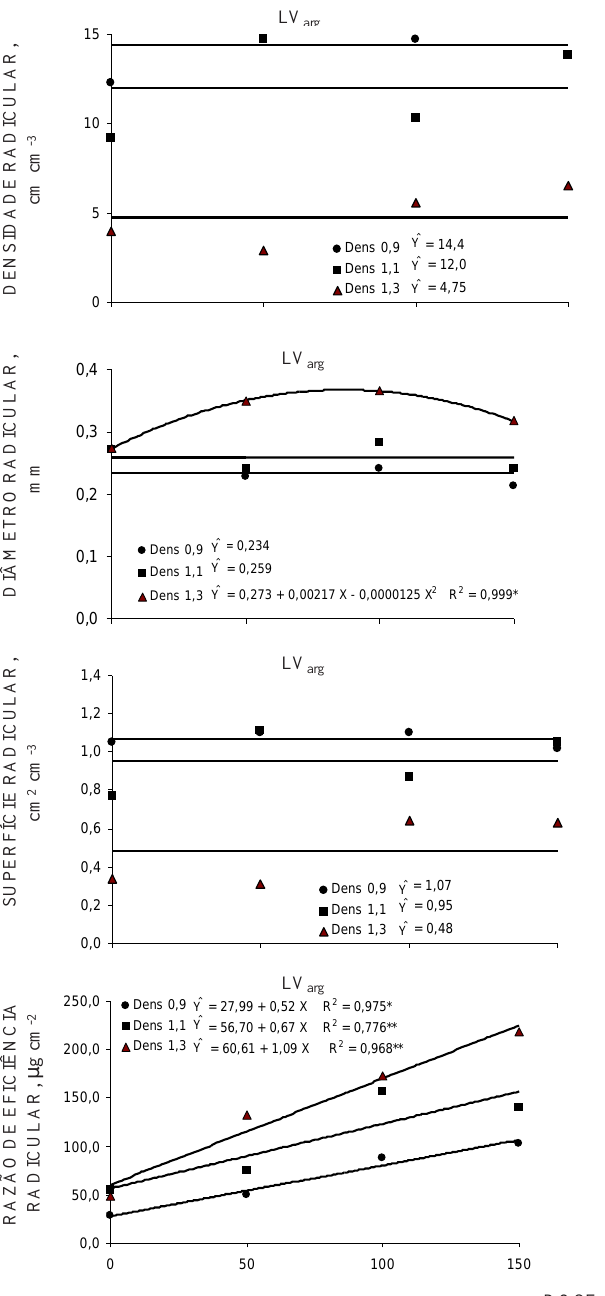
) e franco-arenosa arg